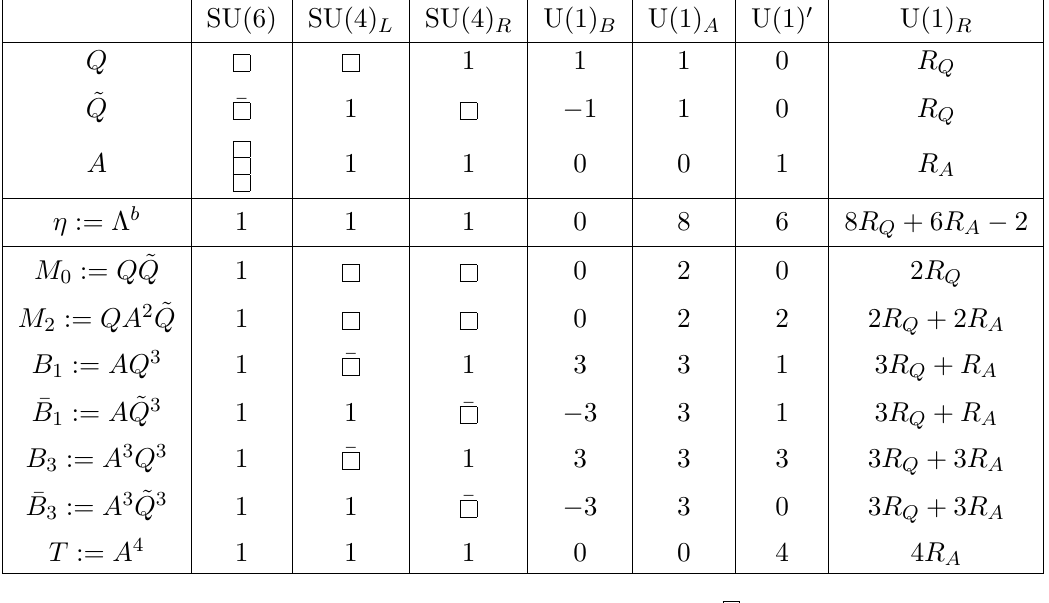
Table 1 . Quantum numbers of 4d N = 1 SU(6) with and 4 ( +